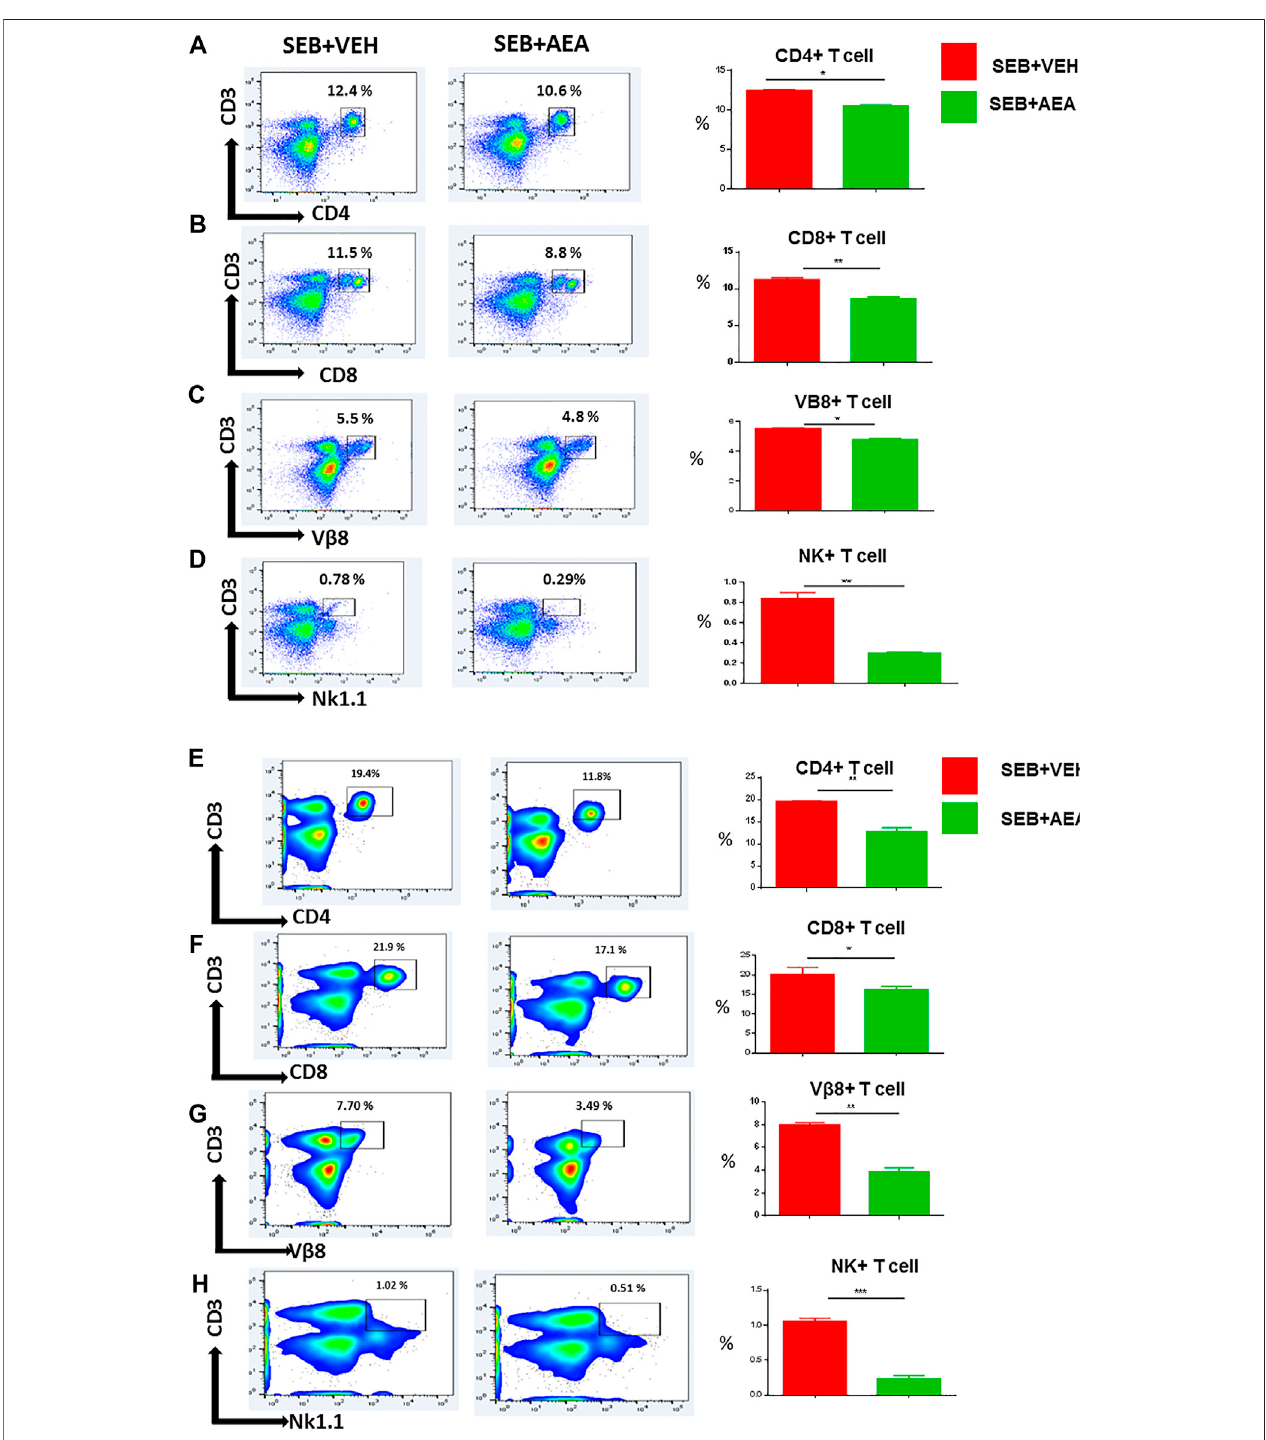
FIGURE 3 | AEA decreases T cell subsets in the splenocytes activated with SEB in vitro . Spleen cells isolated from naïve mice were pretreated with AEA in vitro followed by activation with SEB, and then cultured for 24 (A-D) or 48 (E-H) hrs, and stained for various markers. Each panel shows a representative experiment using fl owcytometry andthe vertical bars depictdatafrom groupsof fi vemice withMean+/-SEM. (A,E) CD3 + CD4 + cells. (B,F) CD3 + CD8 + cells. (C,G) CD3+V β 8+cells (D,H) CD3+NK + cells. The data was con fi rmed in three independent experiments. * p ≤ 0. 05, ** p ≤ 0. 01.